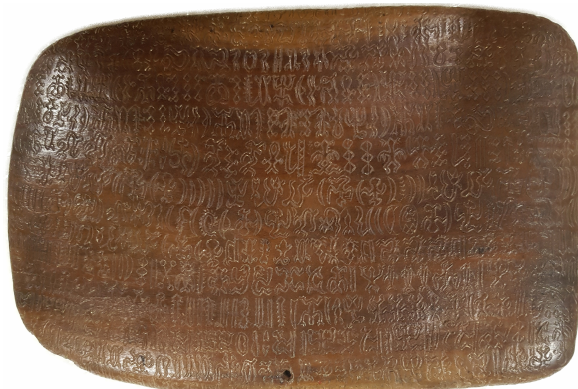
Figure 1: Mamari tablet (side a). Courtesy of Museum Archives